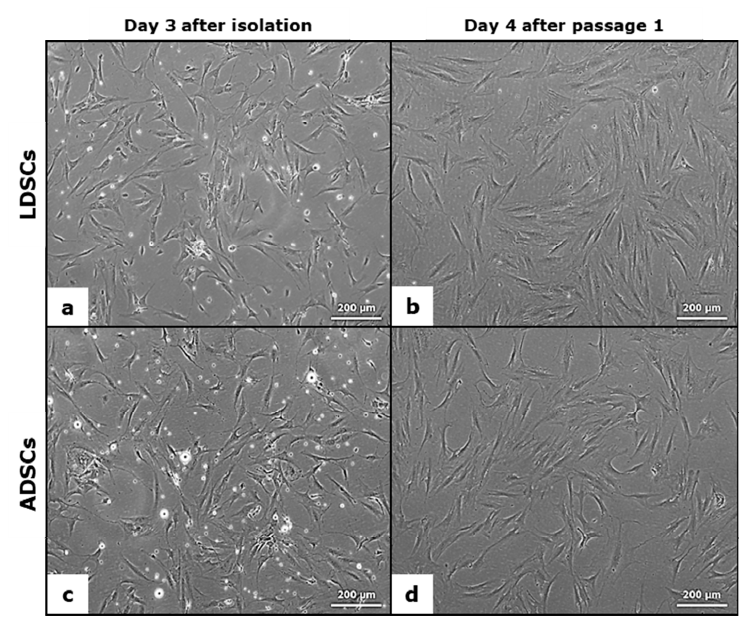
Figure 1. Morphology of lipoma-derived stem cells (LDSCs) ( a , b ) and adipose-derived stem cells (ADSCs) ( c , d ) cultures; Images were acquired at day 3 after isolation ( a , c ) and at day 4 after passage 1 ( b , d ); phase contrast with objective magnification 10×; cells are spindle-like in shape which is typical for mesenchymal stem cells.